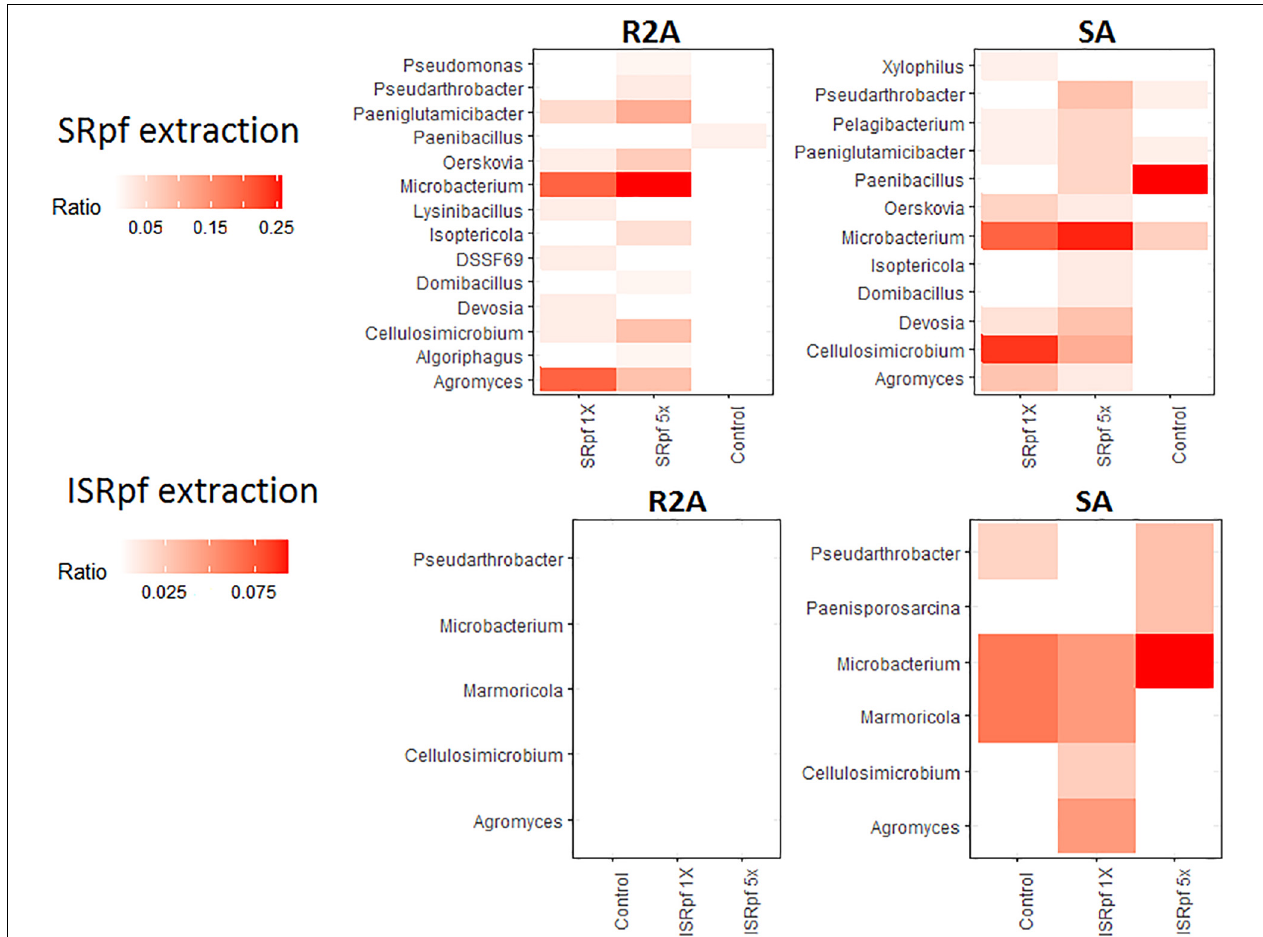
FIGURE 7 | Dominance of each differentially abundant genus from ASV data ( Figure 2 ) on SA or R2A plates, for different extraction strategies (SRpf, upper panels and ISRpf, lower panels). A higher color intensity represents a higher abundance of that genus growing on a specific solid medium. Ratios represent the number of isolates of a particular genus retrieved from a particular condition, divided by all the isolates retrieved from that same specific condition (e.g., from 5 × SRpf-treated soils plated on R2A, i.e., the upper left panel, the second column, Microbacterium comprised 25% of all the retrieved isolates). Only the genera for which a differential abundance was detected in the ASV data are considered in this